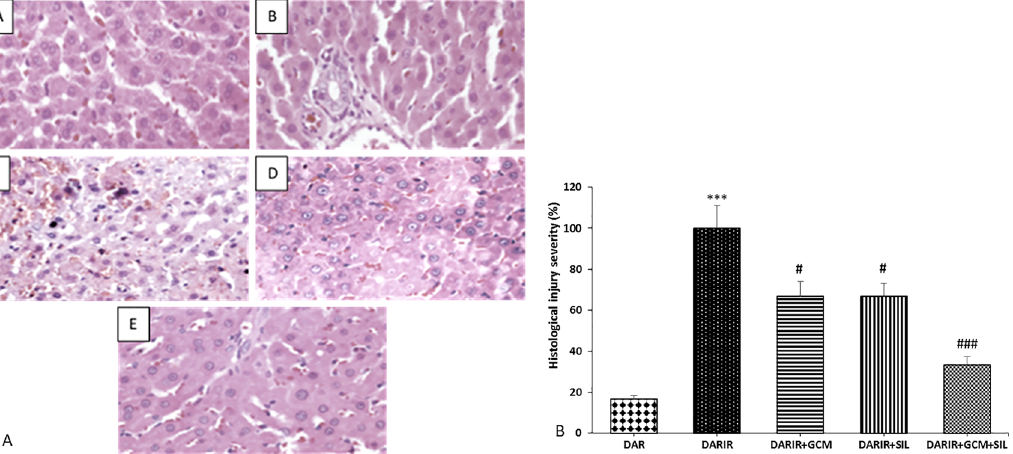
Figure 2: Histopathological changes and severity of hepatic tissues damages. (A) DAR group; (B) DARIR group; (C) DARIR + GCM group; (D) DARIR + SIL group; and (E) DARIR + GCM + SIL group. N=6 for each group. 40 × magni fi cation. DAR, diabetic aged rat; DARIR, diabetic aged rat subjected to ischemia-reperfusion; GCM, ginsenoside compound-Mc1; SIL, silibinin.